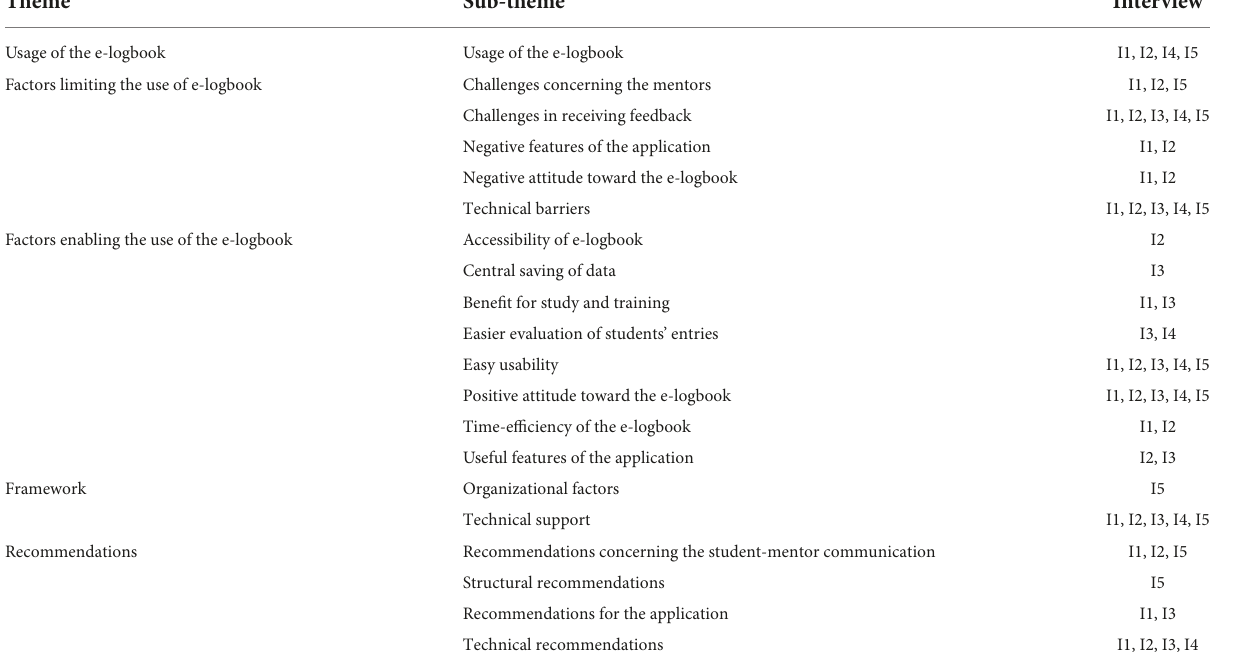
TABLE 1 Overview of assigned categories and respective interviews with their